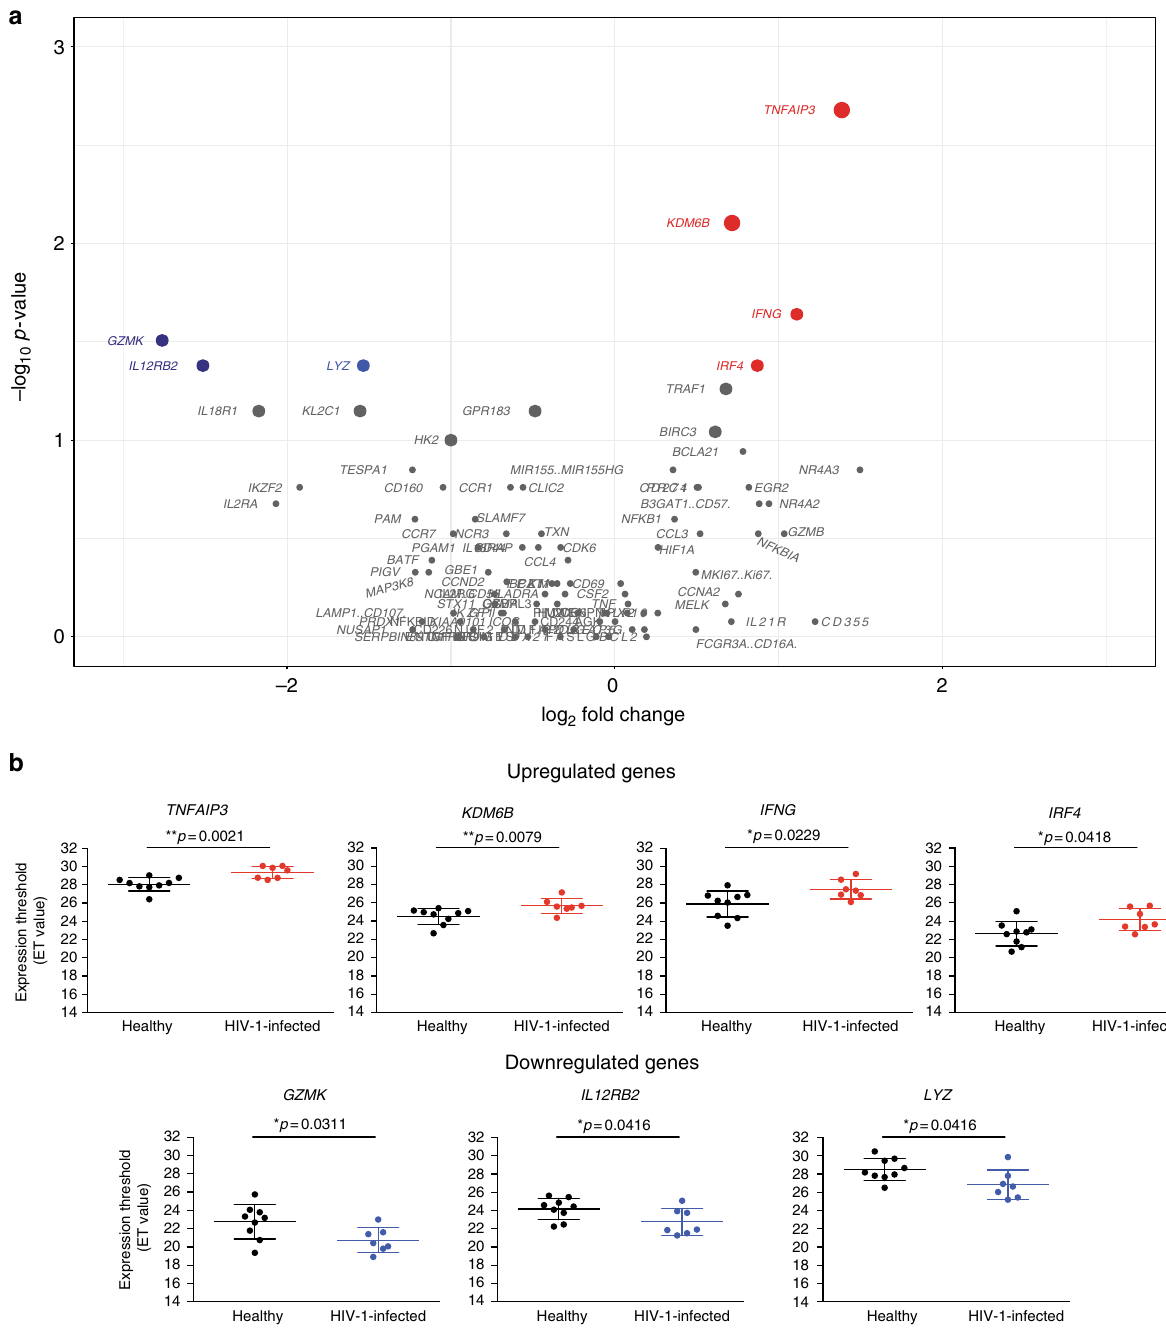
Fig. 5 Gene expression of activated NK cells in chronically infected HIV individuals. a Volcano plot displaying upregulated (red), downregulated (blue), and stably expressed (gray) pre-selected genes, involved in NK cell-mediated responses. Size of each data point is calculated as − log 10 ( p -value) × log 2 (FC), p - value cutoff p < 0.05, fold change cutoff > 2 or <1/2. b Expression threshold (ET) values plotted for top up (red)- and downregulated (blue) genes between healthy volunteers (black) and HIV-1 chronically infected individuals (red or blue). ET values were calculated based on CT values (40-CT) obtained from the qPCR data. Transcriptional analysis from nine healthy subjects and seven HIV-1 chronically infected individuals from two independent experiments is